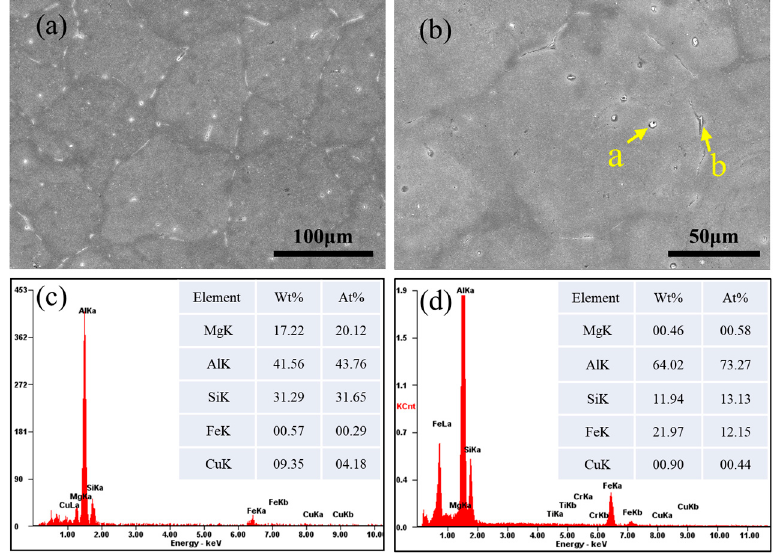
Figure 3. ( a , b ) Microstructure of as-cast alloy; ( c ) composition at point ( a ); ( d ) composition at point ( b